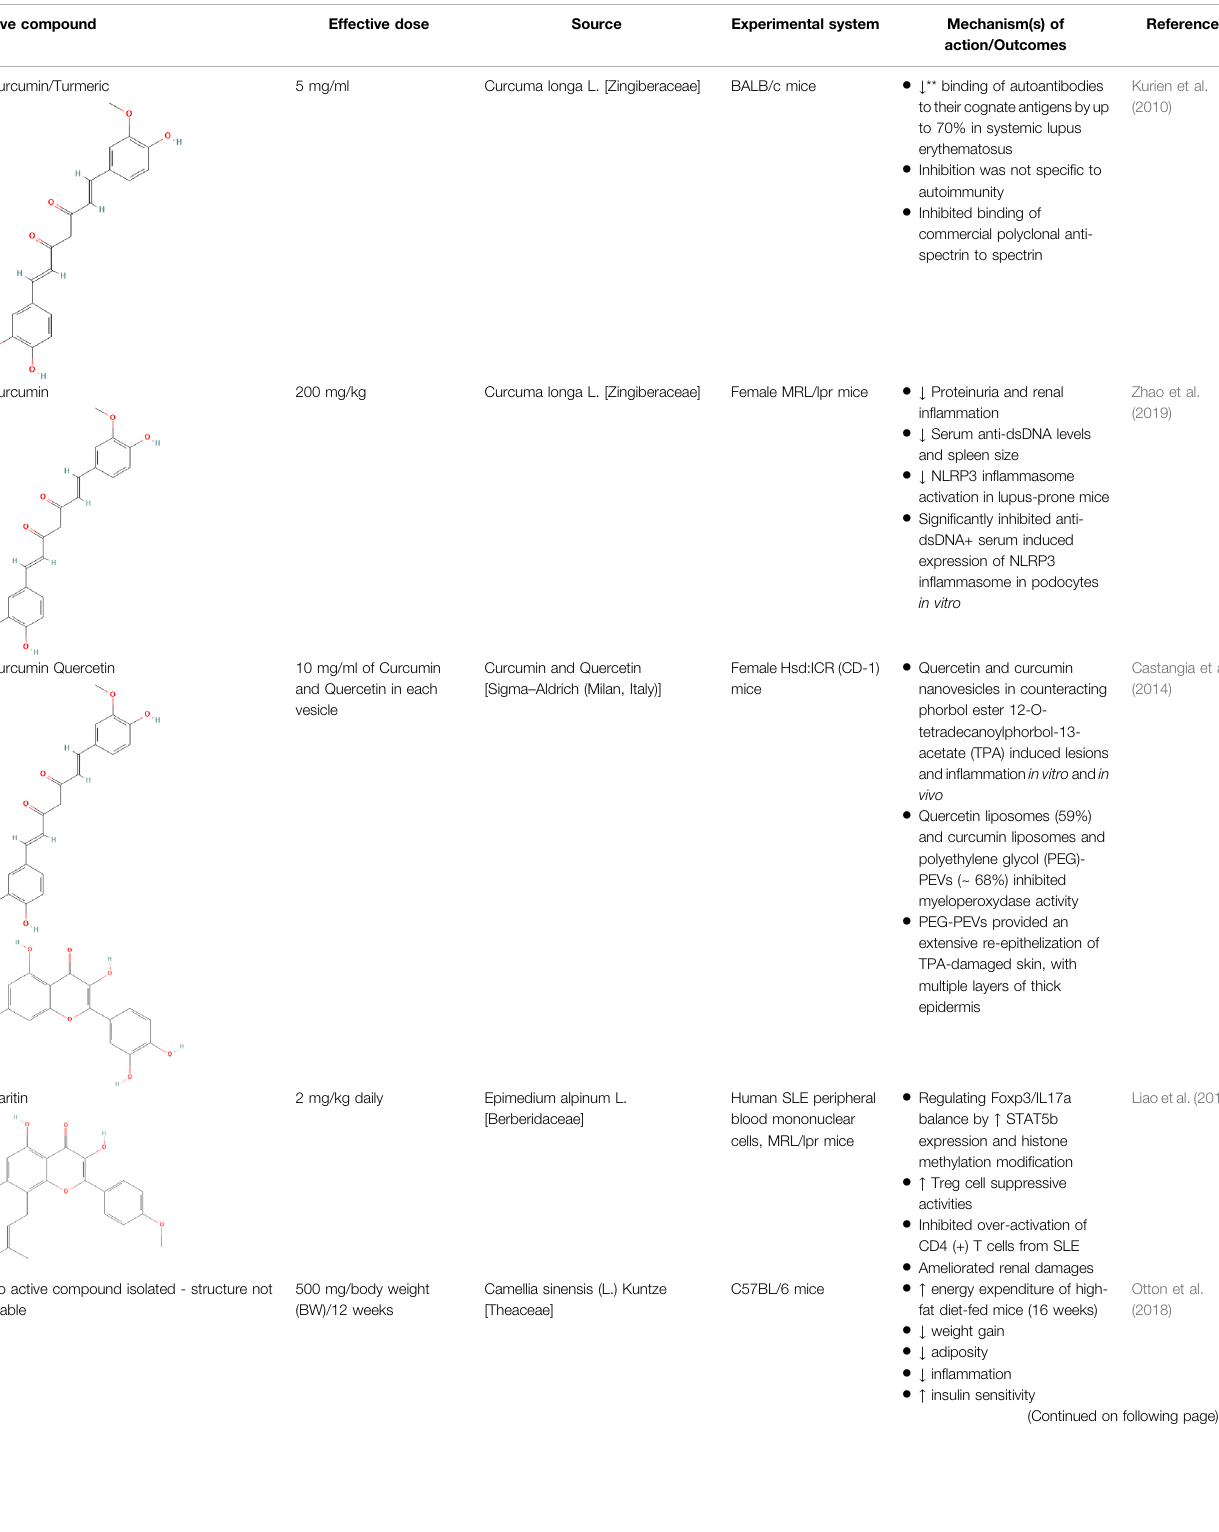
TABLE 1 | ( Continued ) Synthesized fi ndings for potential bioactive compounds for